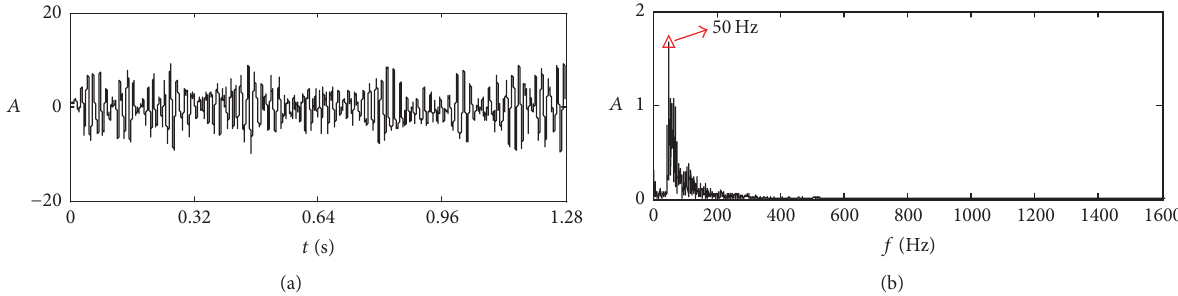
Figure 4: Detection result: (a) the output waveform of SR system; (b) the frequency spectrum of resonance output.